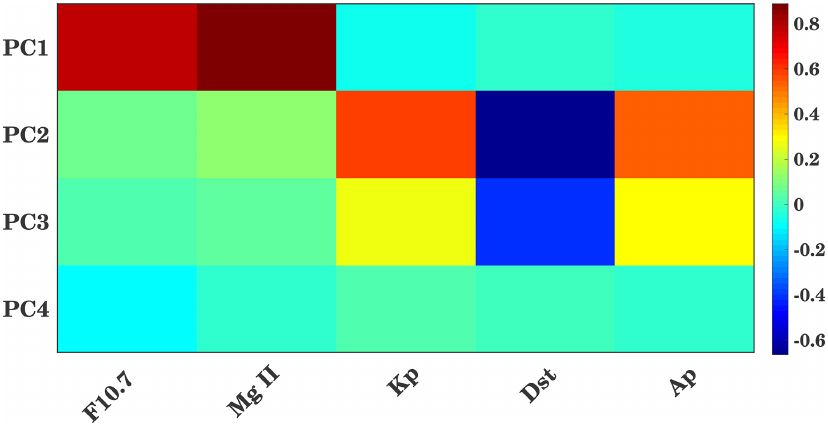
Figure A5. Correlation coefficients between the PCs and solar and magnetic proxies for the 25–35d interval for zero